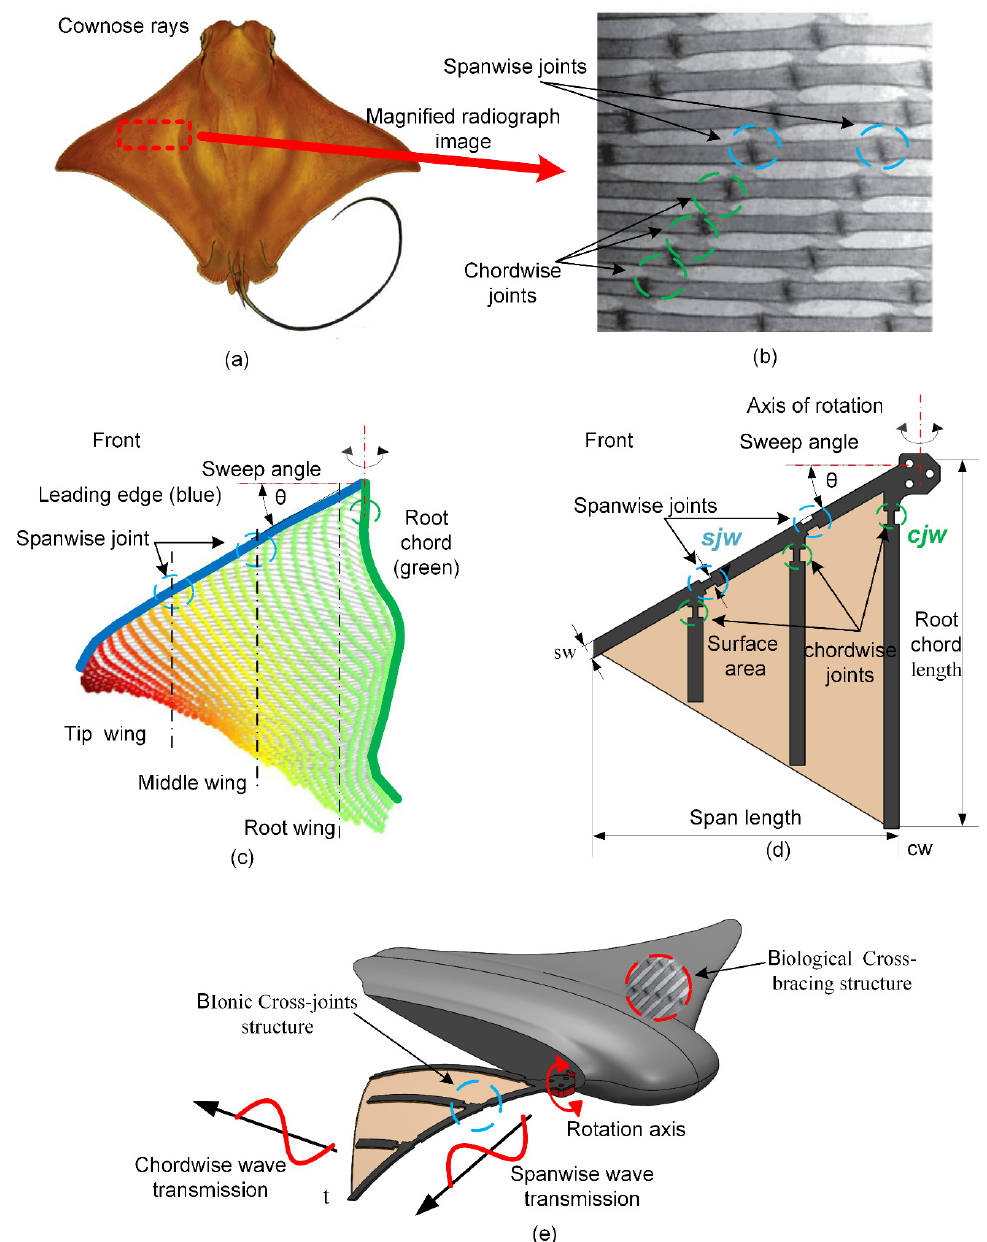
Figure 1. Design of CJF. ( a ) Cownose ray sample; ( b ) cross-bracing structure in the pectoral fins; ( c ) pectoral fins model generated by 3D reconstruction after C.T. scan; ( d ) a basic design of CJF; ( e ) illustration of CJF on the cownose ray